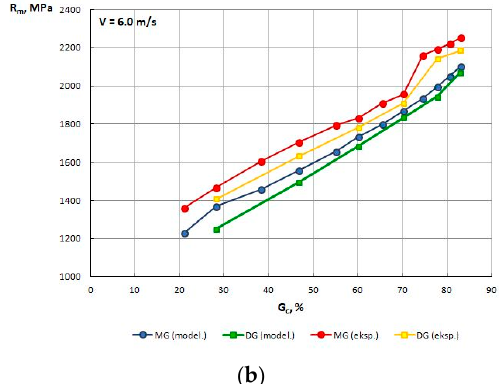
Figure 10. Change in the R m of TRIP steel wires drawn with various speed, and low—MG and high—DG single drawing reductions as a function of the total drawing reduction G c %, obtained through numerical modeling and an experiment. ( a ) Speed drawing V = 1.6 m/s, ( b ) Speed drawing V = 6.0 mm/s. Table 10. The strain level on the wire surface and axis, non-dilatational strain and the temperature determined through a theoretical analysis of the drawing process with low (MG) and high (DG) single section reductions and at various drawing speeds (V c = 1.6 m/s and V c = 6.0 m/s). V c = 1.6 (m/s)